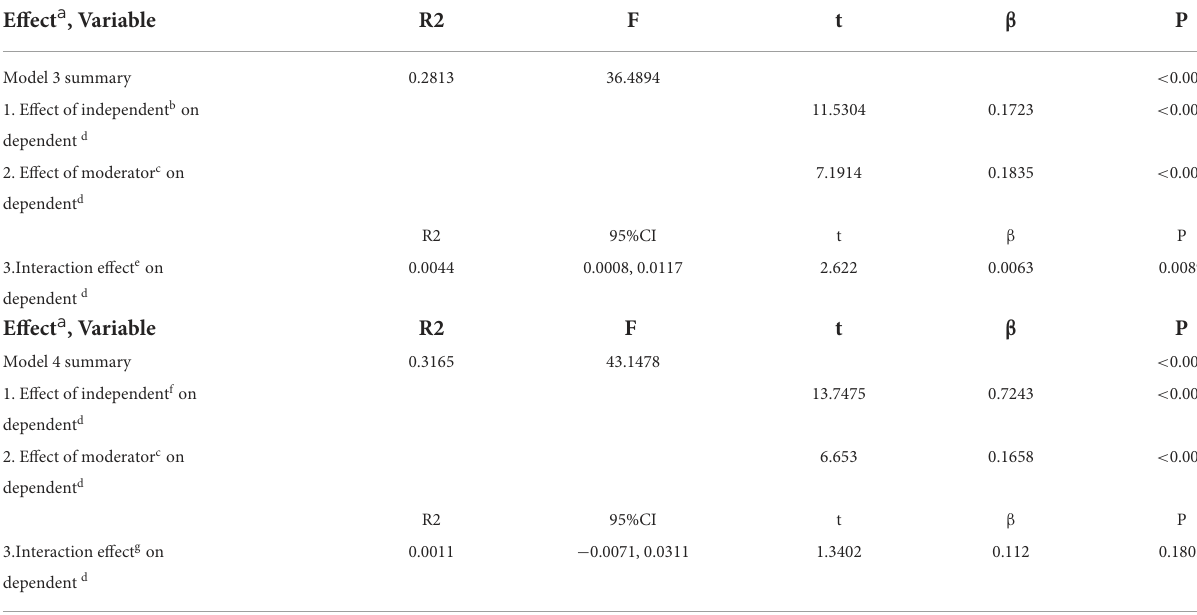
TABLE 3 Result from PROCESS macro testing expressive suppression moderation model 1 and model 2.